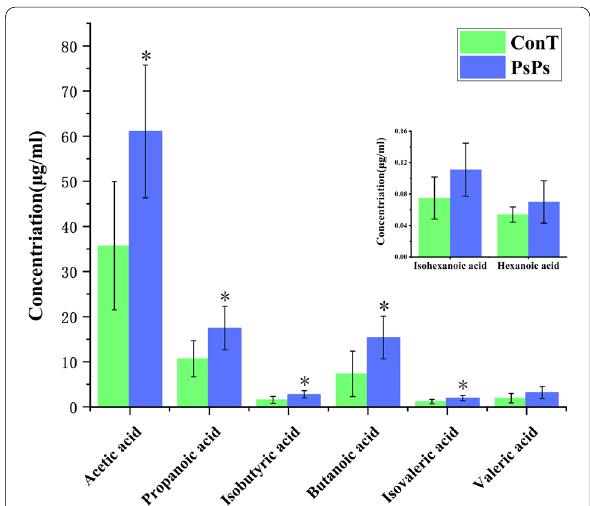
Fig. 4 Changes of SCFAs concentration in feces of mice 3 weeks after PsPs intragastric administration. The Y-axis is the concentration of SCFAs in the samples determined by GC, in units of (ug/ mL), and all samples determined have the same